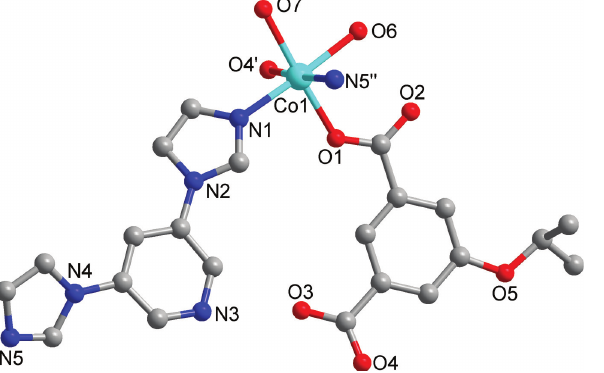
Table 2: Fractional atomic coordinates and isotropic or equivalent isotropic displacement parameters (Å 2